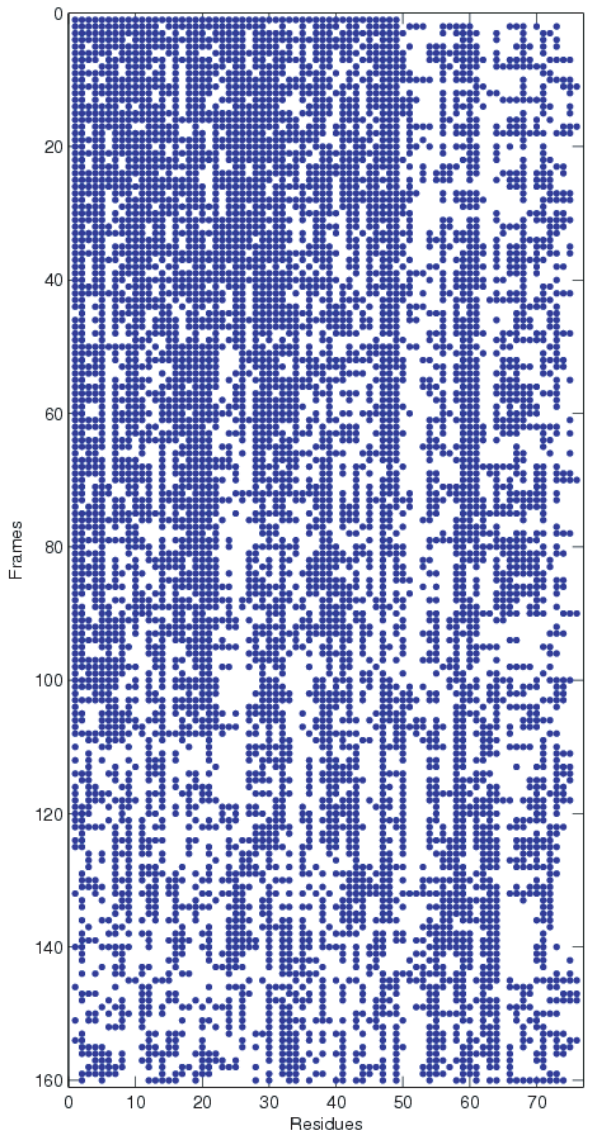
Figure 8. P/z over unfolding: The figure shows a plot of the time evolution of the |P/z| values of all the residues. The residues have been sorted by their values in the first frame such that the HPZ residues are collected together at the left end of the x-axis. A point on the plot indicates |P/z| . 0 implying that the corresponding residue has at least one contact outside its own